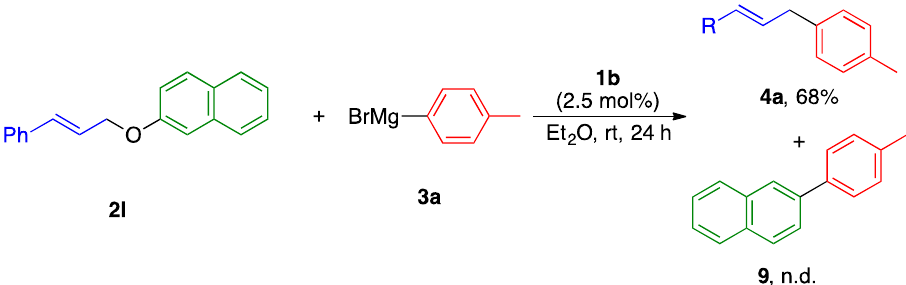
7 Table 5. The cross-coupling reaction of various allylic ethers 2 with 3a . a Entry